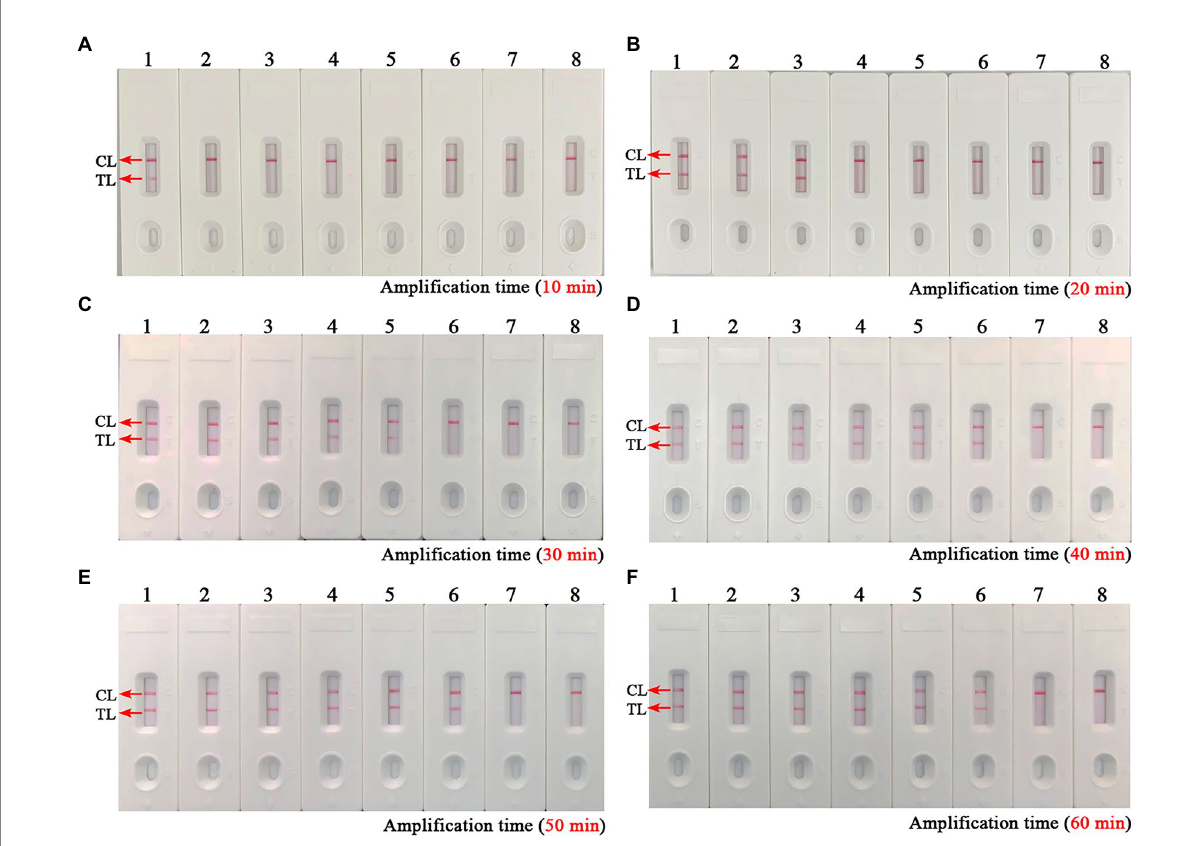
FIGURE 5 Optimal reaction time of the B. abortus -MCDA-LFB assay. The optimal reaction time of the B. abortus -MCDA-LFB assay was explored by examining each diluent of genomic DNA of the B. abortus strain (namely, 1 ng/ μ l, 100 pg/ μ l, 10 pg/ μ l, 1 pg/ μ l, 100 fg/ μ l, 10 fg/ μ l, and 1 fg/ μ l). The plots ( A–F ) correspond to 10 min, 20 min, 30 min, 40 min, 50 min, and 60 min, respectively. Biosensors 1–7 ( A–F ) correspond to 1 ng/ μ l, 100 pg/ μ l, 10 pg/ μ l, 1 pg/ μ l, 100 fg/ μ l, 10 fg/ μ l, and 1 fg/ μ l. Biosensors 8 ( A–F ) correspond to blank control (nuclease-free water). When the reaction time ranged from 40 to 60 min, the LoD of the B. abortus -MCDA-LFB assay was 10 fg/microliter. As a result, the optimal amplification time of B. abortus -MCDA-LFB assay was 40 min ( D ) in the current study. MCDA, multiple cross displacement amplification; AuNPs-LFB, gold nanoparticles-based lateral flow biosensor; TL, test line; CL, control